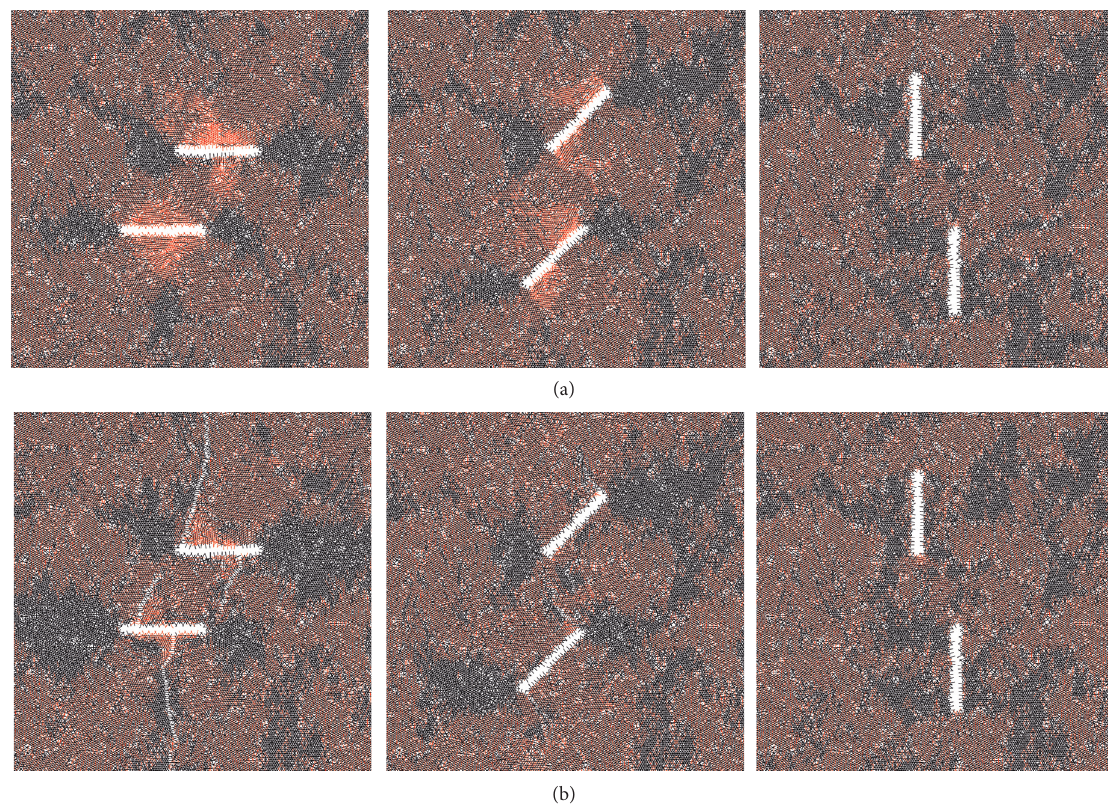
Figure 5: Contact force chain of samples containing unfilled flaws with the same β of 120 ° and different α of 0 ° , 45 ° , and 90 ° at the (a) crack initiation moment and (b) peak stress moment (red contact force chain represents tension and black contact force chain represents